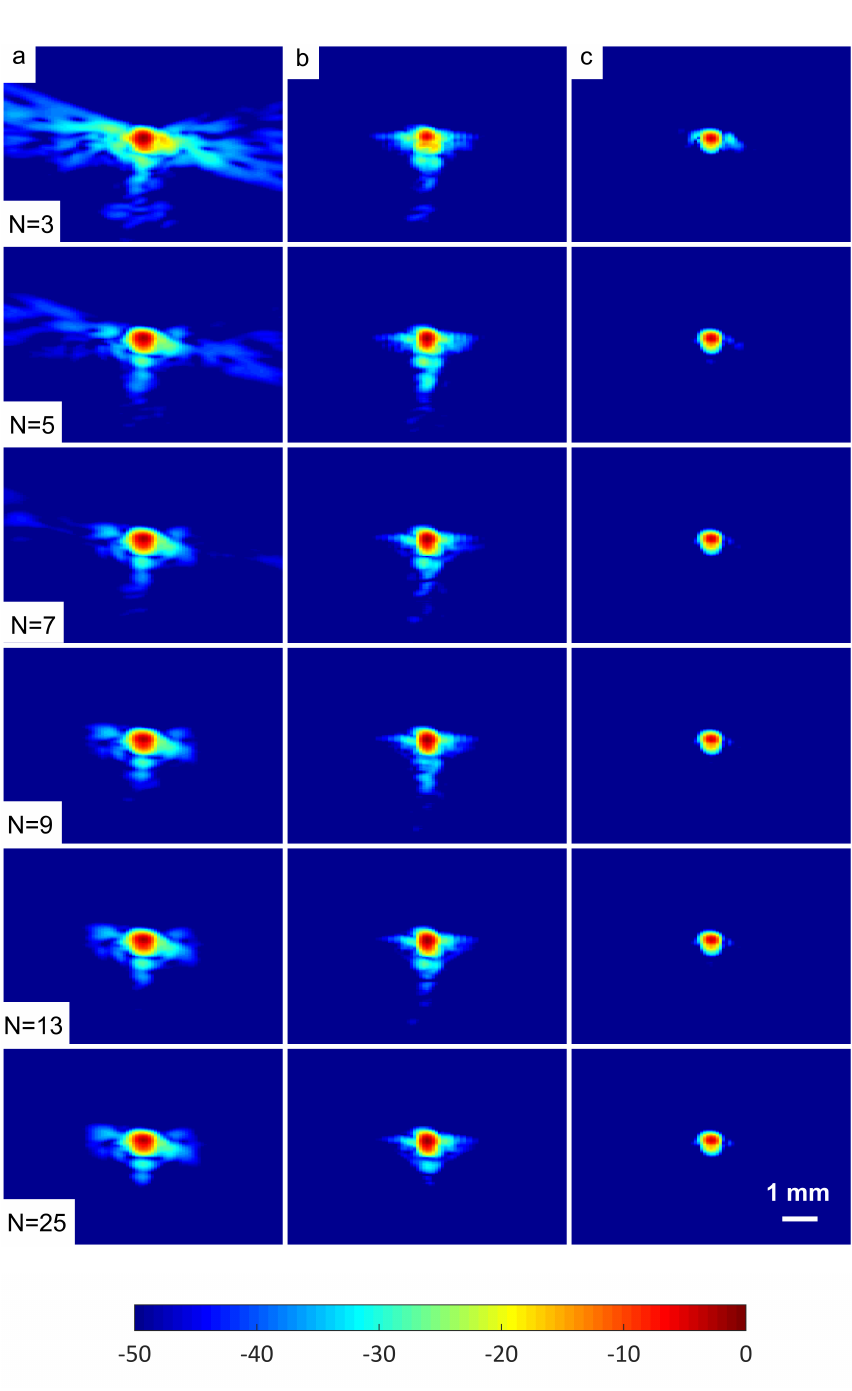
Figure 10. B-mode images with plane waves ( N = 3 to N = 25) for the wire target at a depth of 30 mm beamformed with ( a ) DAS, ( b ) FDMAS and ( c ) DAS-FMAS. The side-lobe reduction in the lateral direction starts to improve with DAS-FMAS at the lowest number of compounding angles, N =